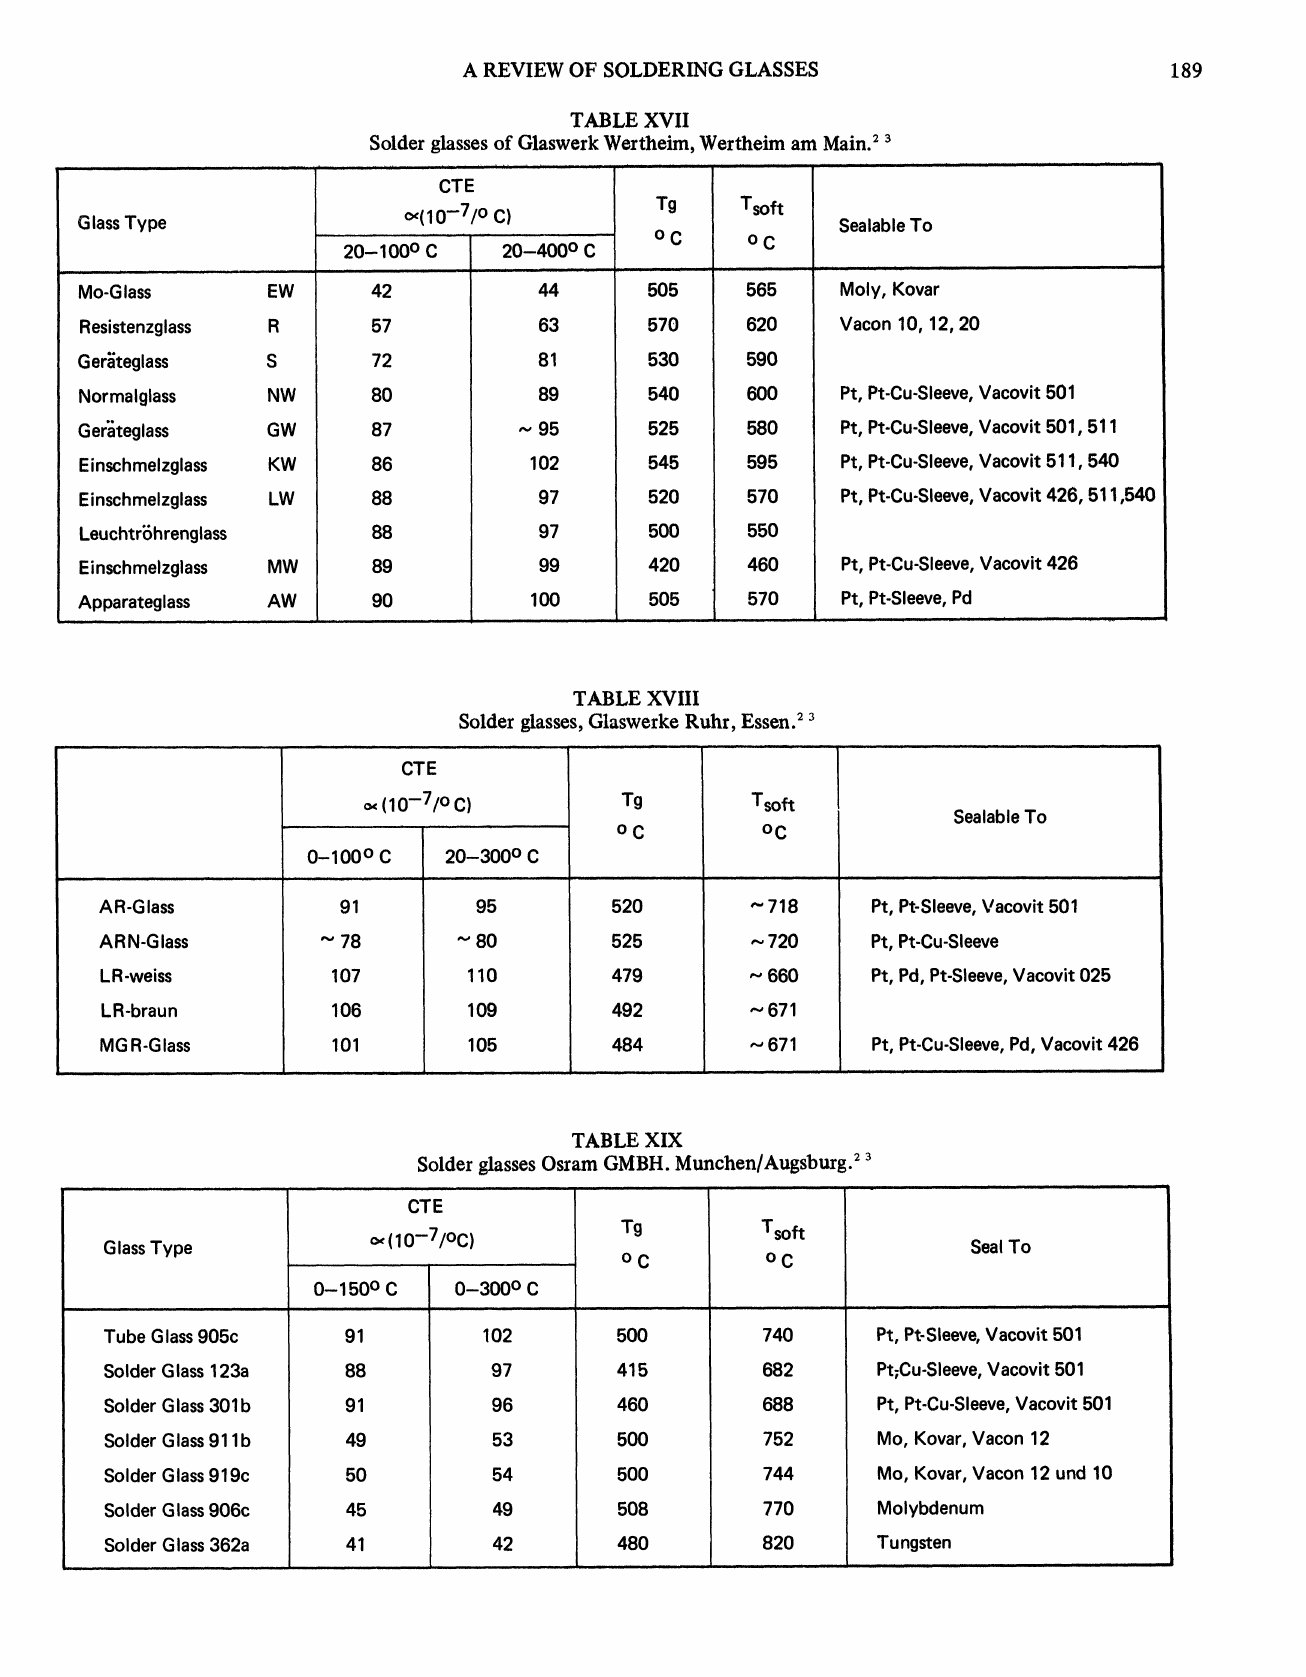
TABLE XlX Solder glasses Osram GMBH.